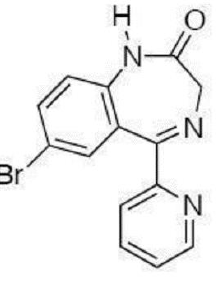
Figure 1. Chemical structure of bromazepam (BRZ).